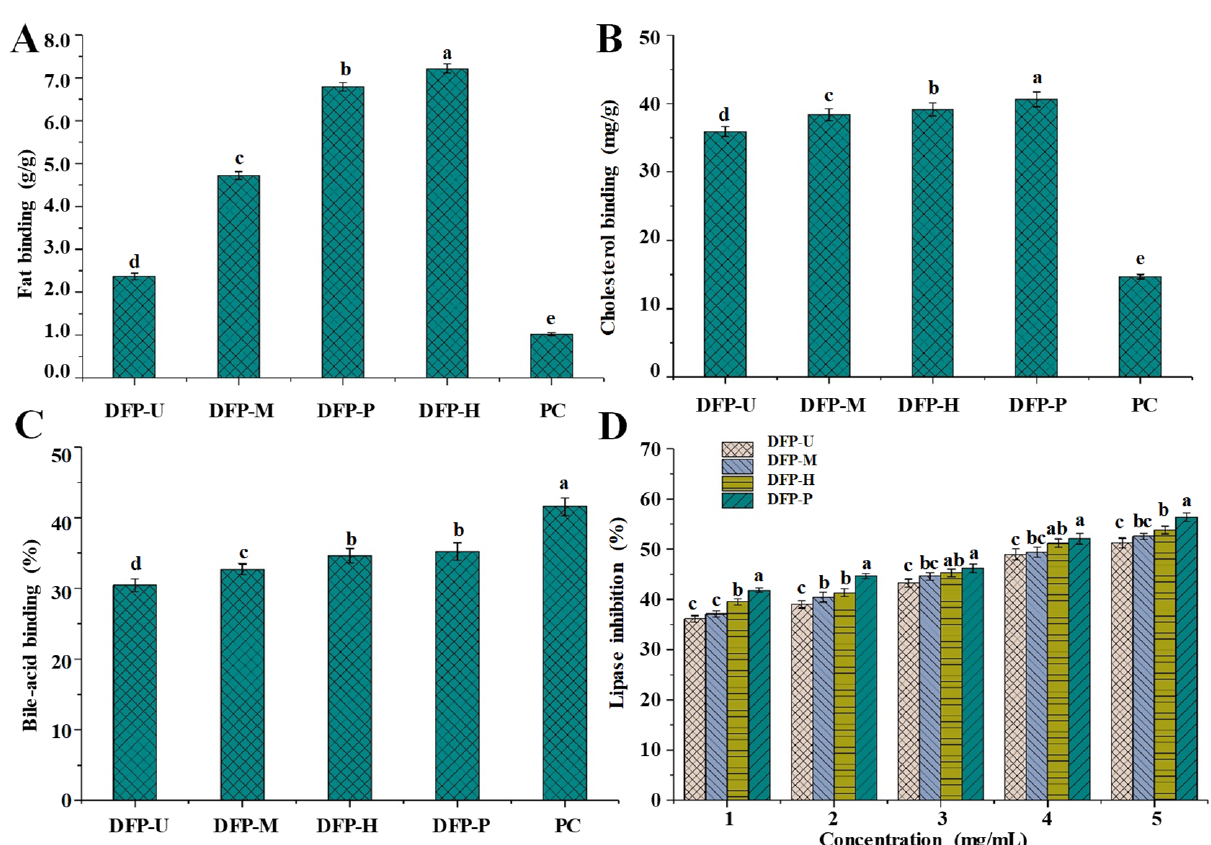
Figure 4. The in vitro fat-binding ( A ); cholesterol-binding ( B ); bile-acid binding ( C ) capacities, and in vitro inhibitory effects on the pancreatic lipase ( D ) of DFP-H, DFP-M, DFP-U, and DFP-P ( D. indusiata polysaccharides extracted by HWE, MAE, UAE, and PAE respectively); PC, positive control; Values represent mean ± standard deviation, and the letters (a–e) differ significantly ( p < 0.05) among fat-binding, cholesterol-binding, bile-acid binding capacities, and inhibitory effects on the pancreatic lipase of D. indusiata polysaccharides prepared by different extraction methods and the positive control, respectively. Statistical significances were carried out by ANOVA plus post hoc Duncan’s test.